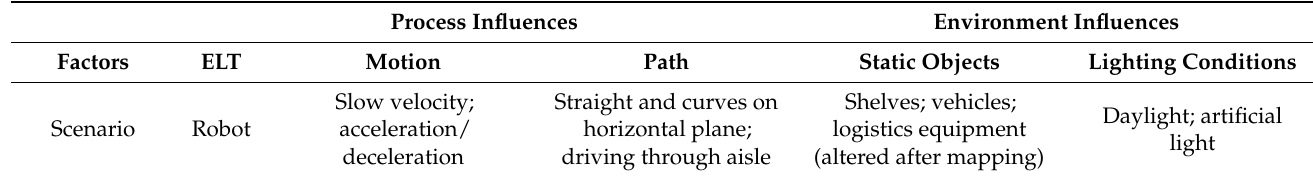
Table 5. Application-dependent Scenario for an AGV in warehouse